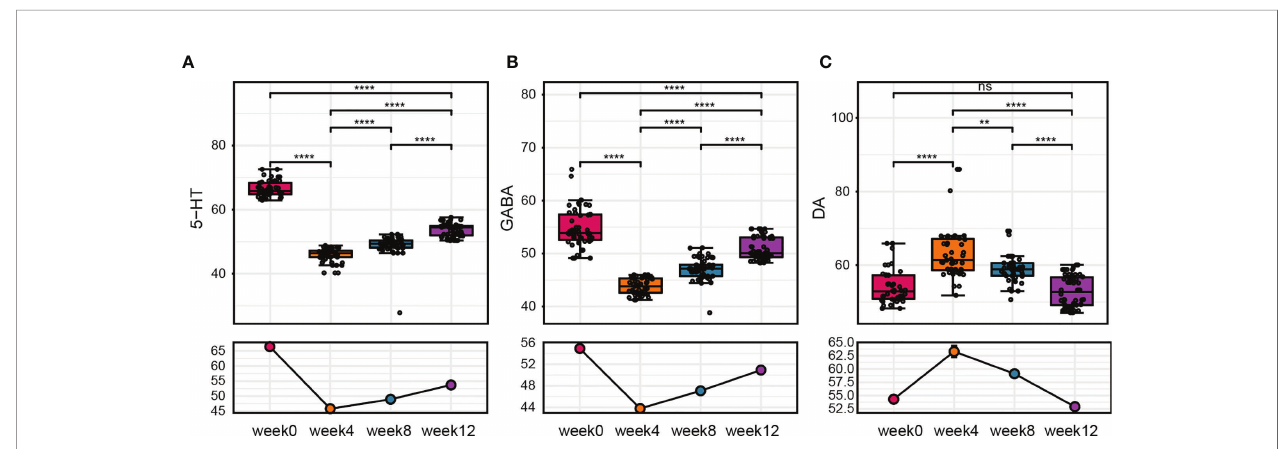
FIGURE 3 | The change in neurotransmitter levels after FMT. (A – C) Changes in 5-HT, GABA, and DA levels at before treatment, after treatment, and 8 weeks after treatment. The Wilcoxon signed-rank test was used to determine the signi fi cance. **P < 0.01, ****P < 0.0001, ns, no signi fi